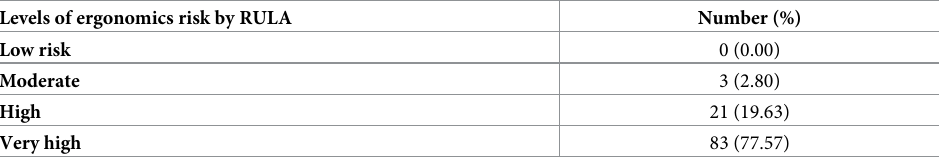
Table 2. The number and percentage of potato-chip processing workers classified by level of ergonomics risk by RULA (n = 107). Levels of ergonomics risk by